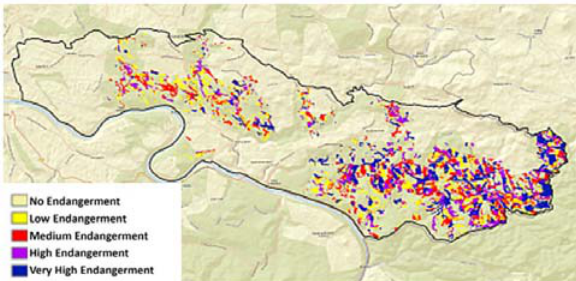
Figure 13. Prediction map for endangerment of infection by Ips Typographus L. in the National Park